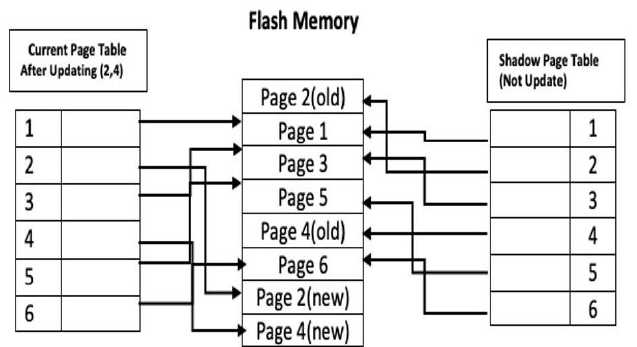
Figure 6. Example of RSLSP